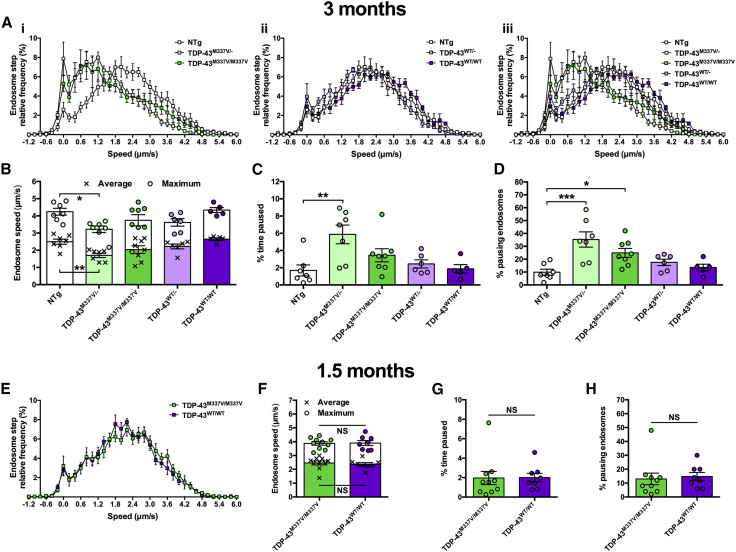
TDP-43M337V Transport Disruption Occurs between 1.5 and 3 Months(A) Endosome frame-to-frame speed distribution curves show that at 3 months TDP-43M337V (i, iii, green), but not TDP-43WT (ii, iii, purple), mice transport endosomes more slowly than control, non-transgenic (NTg) mice (white).(B) Mean (crosses, p = 0.004, one-way ANOVA) and maximum (circles, p = 0.0222, one-way ANOVA) endosomal speeds are significantly reduced in TDP-43M337V/− mice.(C and D) TDP-43M337V hemizygotes and homozygotes show increased endosome pausing as assessed by calculating the percentage of time paused (C) (p = 0.0171, Kruskal-Wallis test) and the percentage of pausing endosomes (D) (p < 0.001, one-way ANOVA).(E–H) At 1.5 months, there is no difference in endosome frame-to-frame speed distribution curves (E), average or maximum endosome transport speeds (F), the percentage of time that endosomes were paused (G), or the percentage of pausing endosomes (H) between TDP-43M337V/M337V (green) and TDP-43WT/WT (purple) mice. This suggests that transport disruption occurs between 1.5 and 3 months. Presented 1.5 month data are not significantly different from NTg control (not shown).∗p < 0.05, ∗∗p < 0.01, and ∗∗∗p < 0.001, Dunnett’s/Dunn’s multiple-comparisons test. NS, not significant, unpaired t test/Mann-Whitney U test. n = 5–10. Means ± SEM are plotted for all graphs.See also Figures S2 and S4.